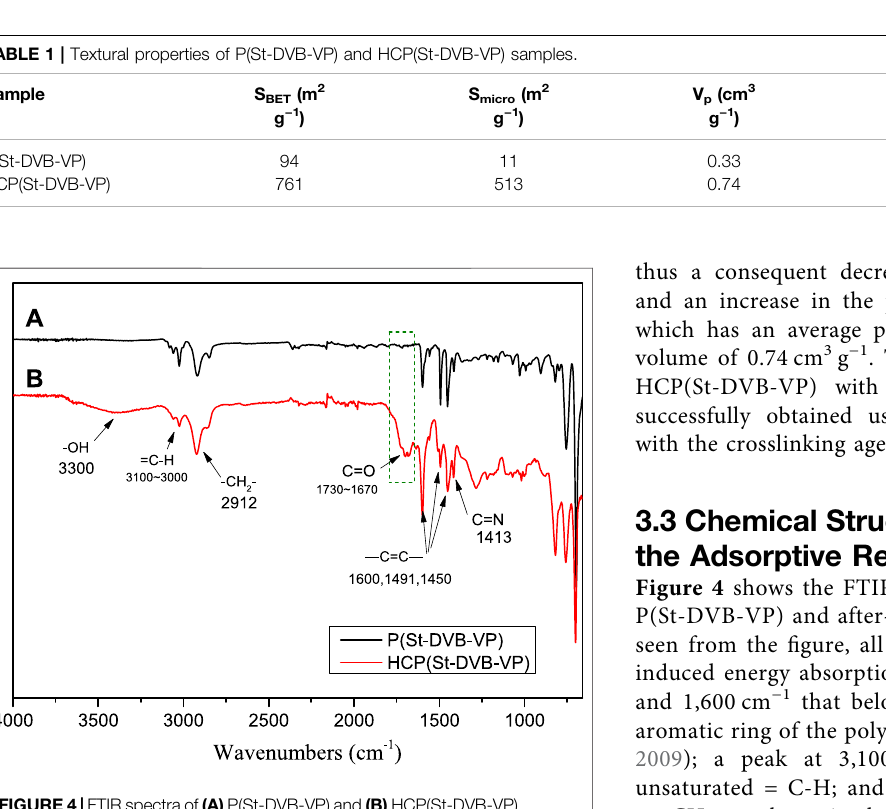
FIGURE4| FTIRspectraof (A) P(St-DVB-VP)and (B) HCP(St-DVB-VP).